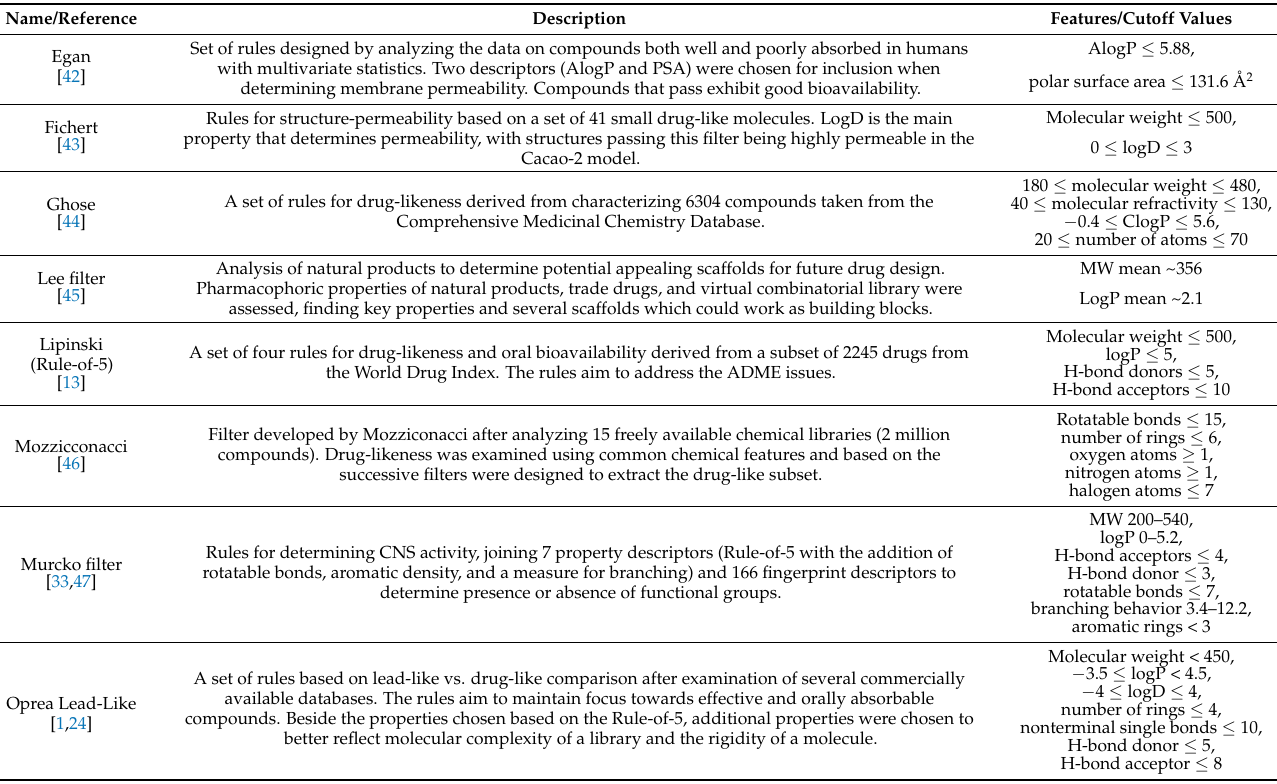
Table 2. The most common property filters described in the scientific